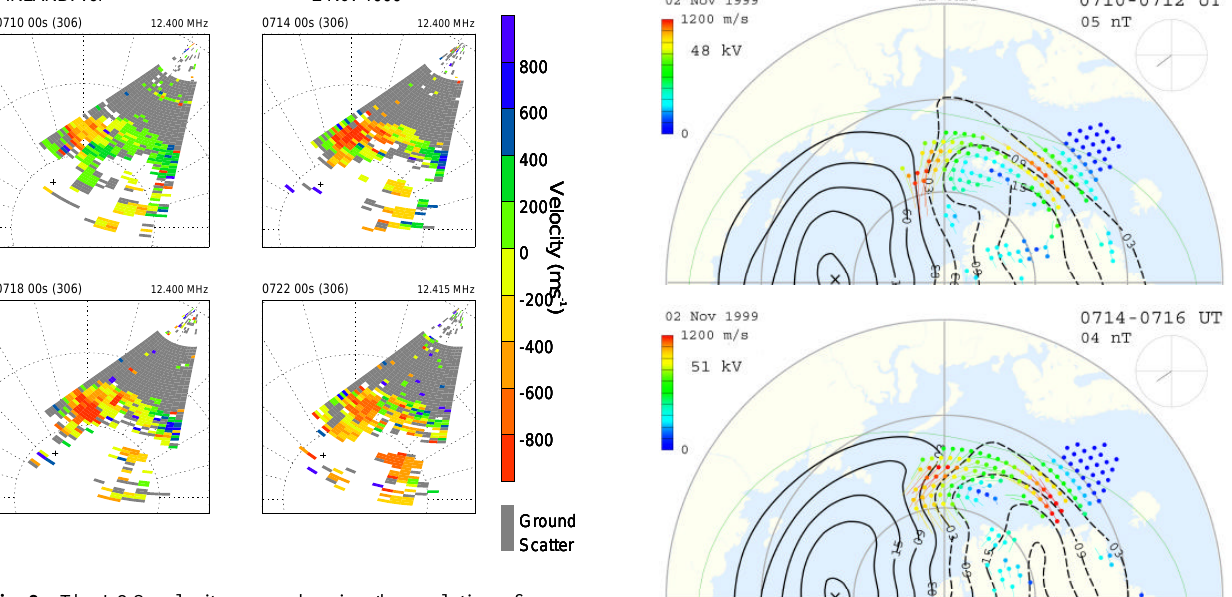
Fig. 8. The LOS velocity maps showing the evolution of a flow channel in the field-of-view of the Finland radar that was located at ∼ 10:00 MLT (12:00 MLT is toward the top). The 80 ◦ , 70 ◦ and a small fraction of 60 ◦ magnetic latitudes are shown. The cross shows the north geographic pole. The ground-scatter is shown in gray. Fig.9